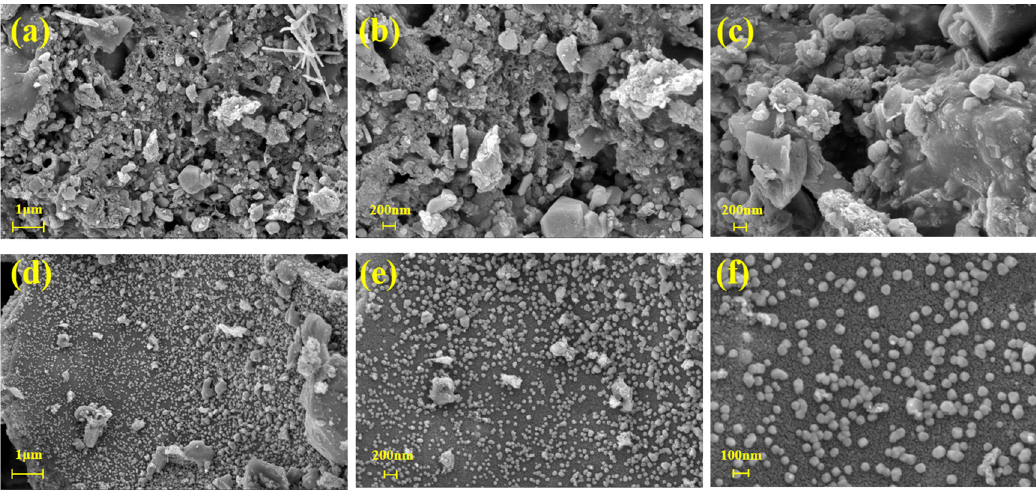
Figure 2. SEM images of ( a – c ) SB and ( d – f ) SB-NZVI(1:4-900).